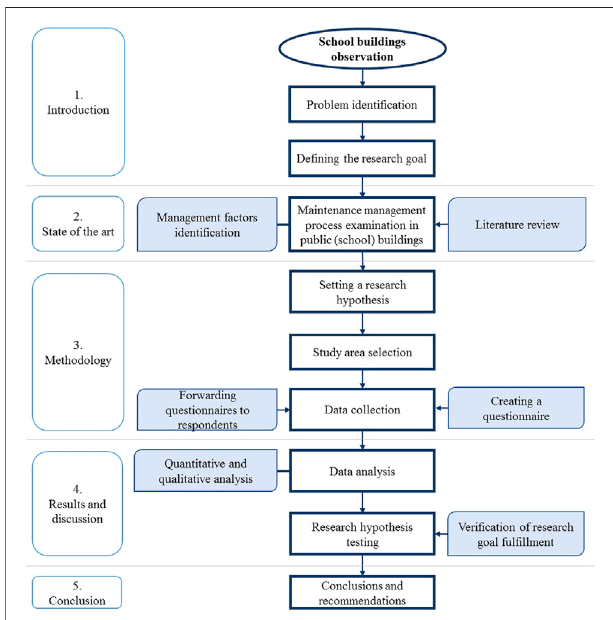
FIGURE 2 | Research methodological